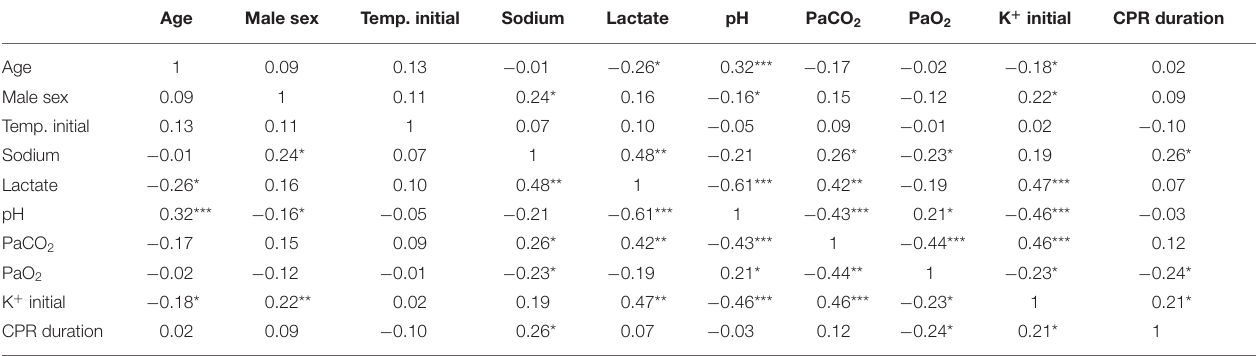
TABLE 4 | Correlations between clinical and laboratory variables of a subset of victims of hypothermic cardiac arrest displaying individual data undergoing attempted rewarming by means of ECSL (ECMO or/and CPB). Age Male sex Temp. initial Sodium Lactate pH PaCO 2 PaO 2 K +